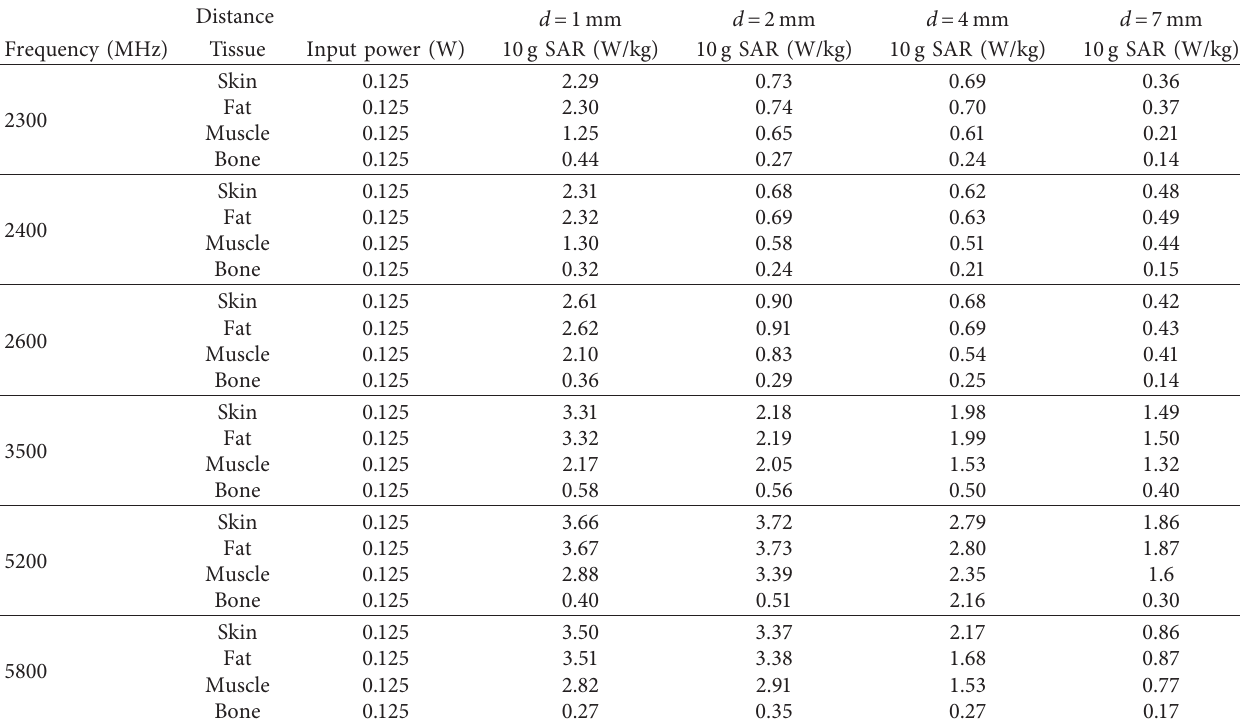
Table 5: SAR result table of antenna mounted on the